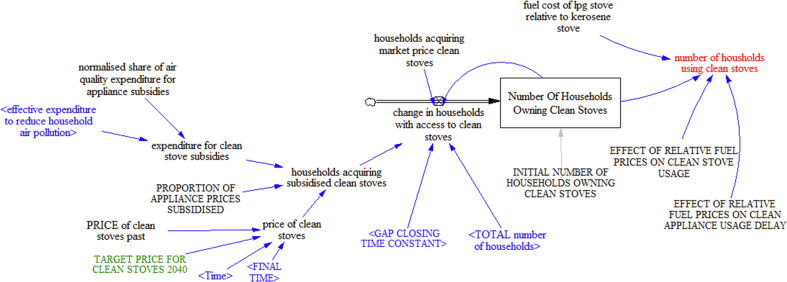
Formulation of number of households using clean stoves.